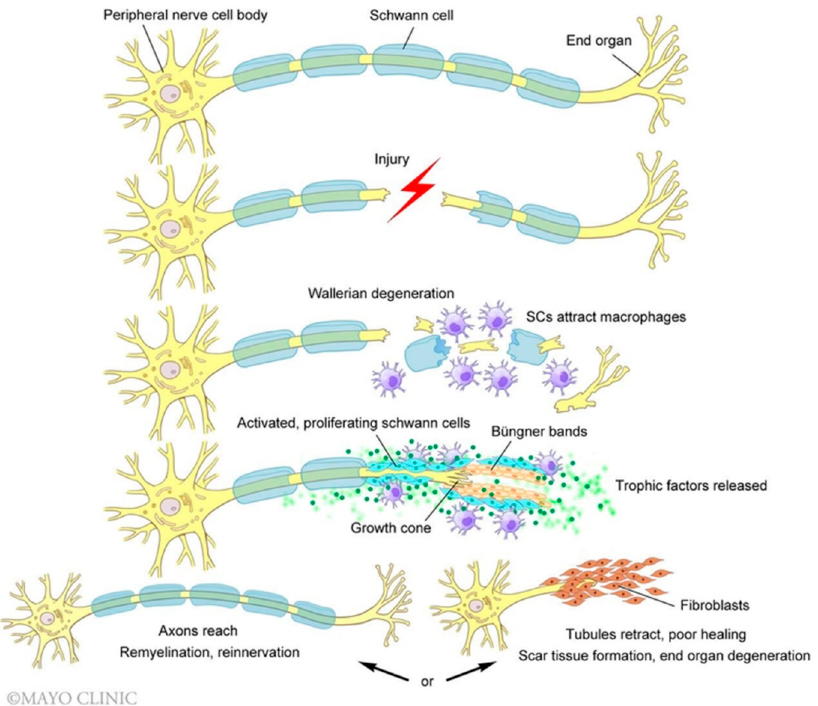
Figure 1. Activated Schwann cells (SCs) and recruited macrophages phagocytose axonal and myelin debris following a nerve injury. Neurotrophic factors stimulate SCs to replicate and extend over arrays of extracellular matrix proteins to form the bands of Büngner, which guide the extending growth cone across the site of injury. Prolonged denervation can result in poor nerve regrowth and target scar formation. (Used with permission of Mayo Foundation for Medical Education and Research, all rights reserved.)